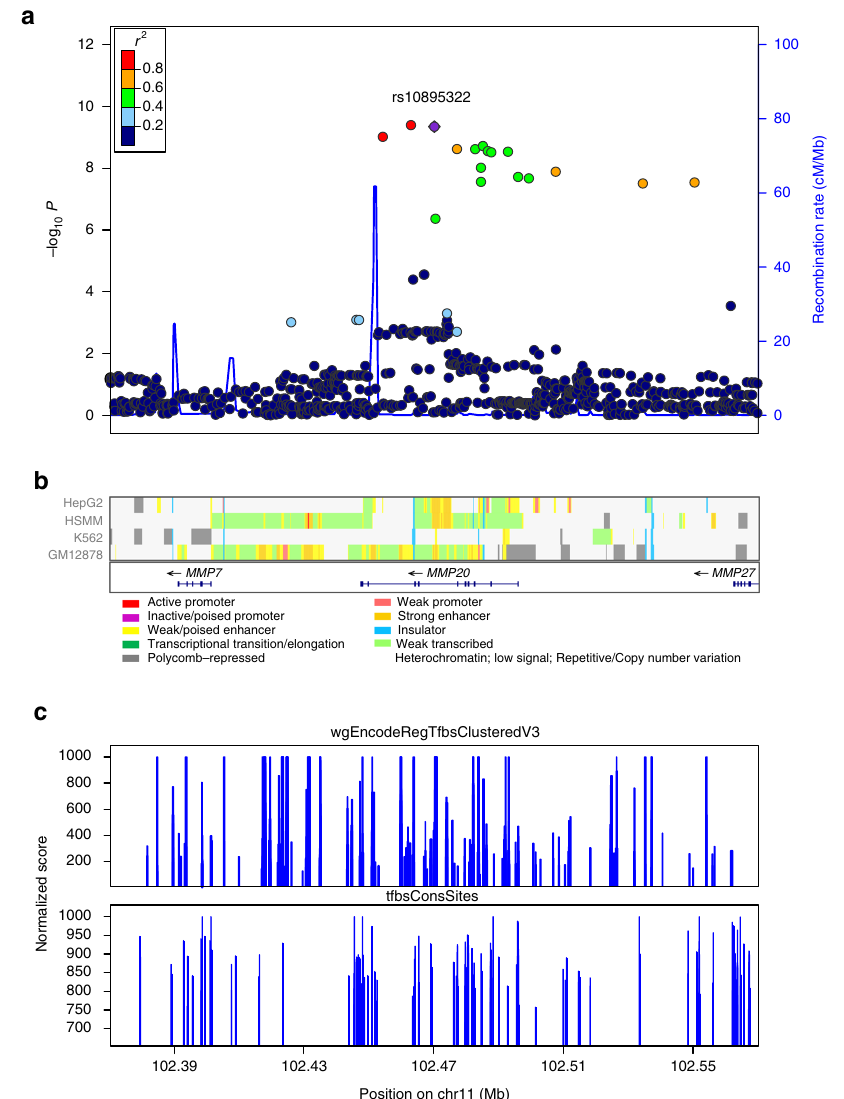
Fig. 1 Regional association plot including both genotyped and imputed SNPs at 11q22.2. a Plotted are the regional association results from the meta-analysis of discovery and replication cohorts ( − log10 transformed P values) and the recombination rate. SNPs are colored to re fl ect pairwise LD ( r 2 ) with the most signi fi cantly associated SNP. The most signi fi cant SNP is shown in purple . The tracks of b CHROMHMM (Celline: HepG2, HSMM, K562, GM12878), c wgEncodeRegTfbsClusteredV3 and tfbsConsSites annotation are plotted on the